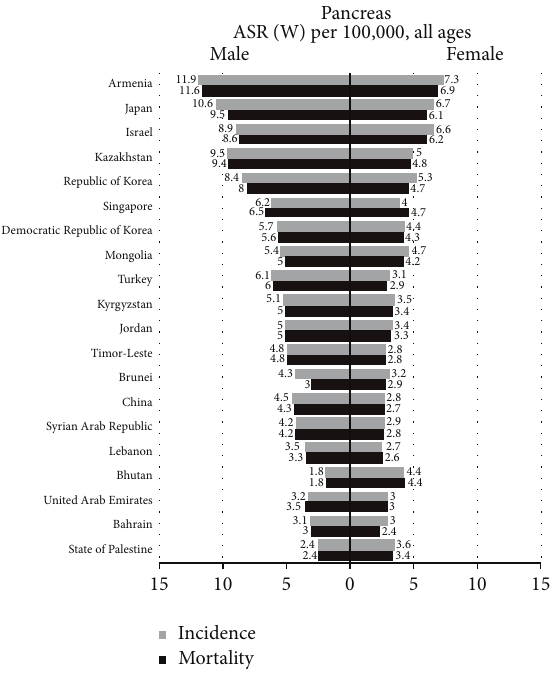
Figure 2: Age-standardized incidence and mortality rates for pancreatic cancer in males and females, China, 2012, from the International Agency for Research on Cancer. GLOBOCAN 2012 (IARC) (13.7.2014)